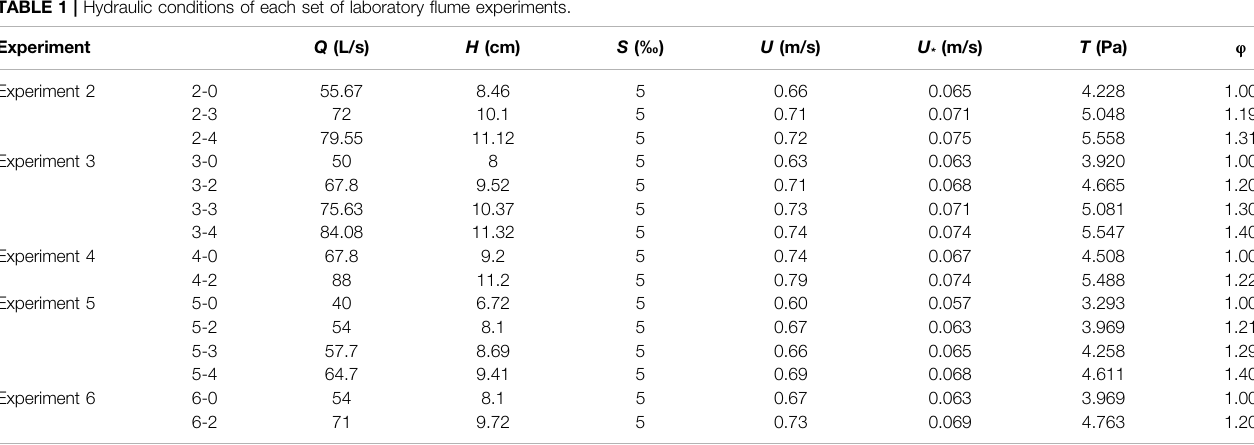
The experimental data for this study were selected from Wang et al.